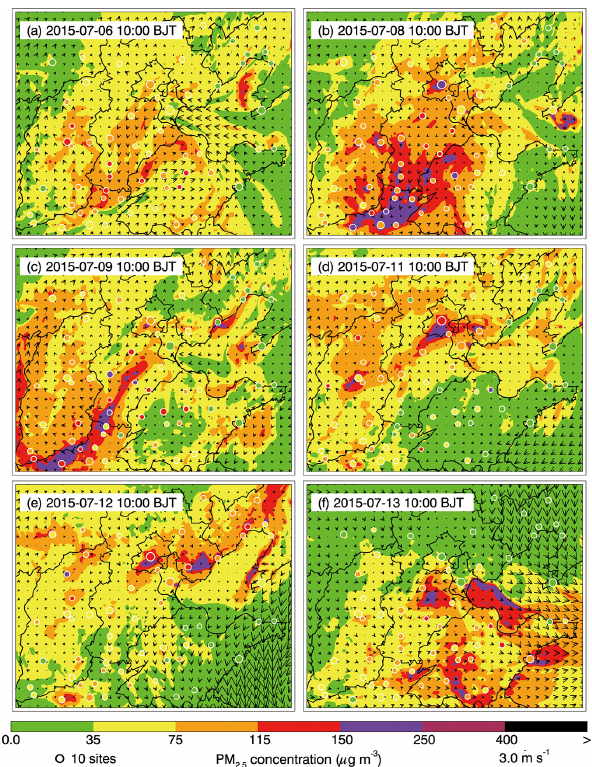
Figure 6. Pattern comparison of simulated vs. observed near- surface PM 2 . 5 at 10:00BJT during the selected periods from 5 to 14 July 2015. Colored circles: PM 2 . 5 observations; color contour: PM 2 . 5 simulations; black arrows: simulated surface winds.